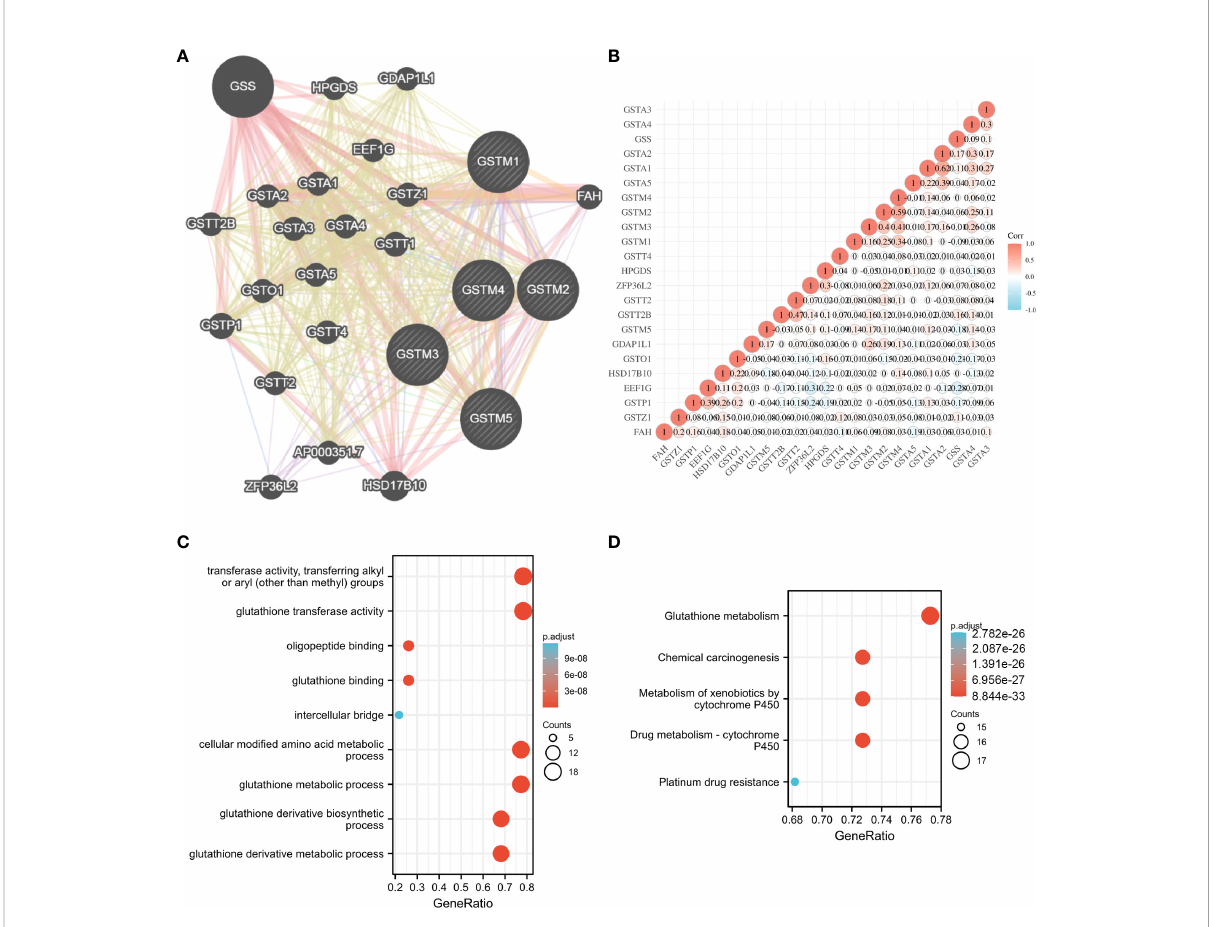
FIGURE 4 The potential molecular function of GSTMs in OC. (A) The PPI network associated with GSTM1-5 based on GeneMANIA database. (B) Correlation heat map of PPI network based on TCGA database. (C) The GO enrichment of PPI network genes. (D) The KEGG enrichment of PPI network